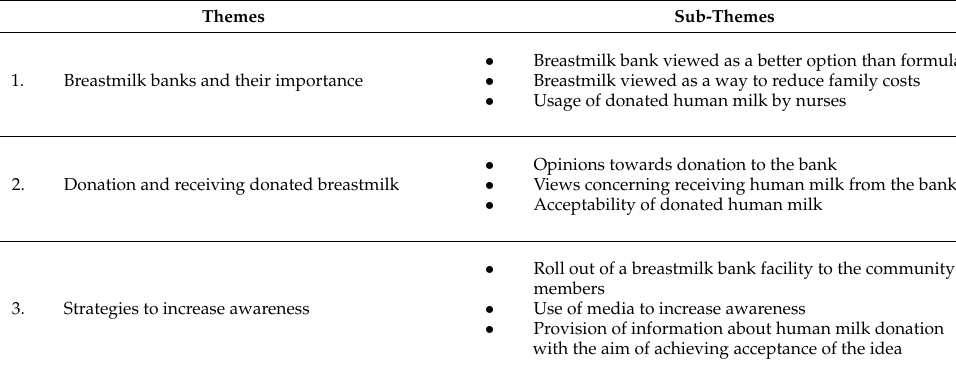
Table 1. Themes and sub-themes that emerged from the